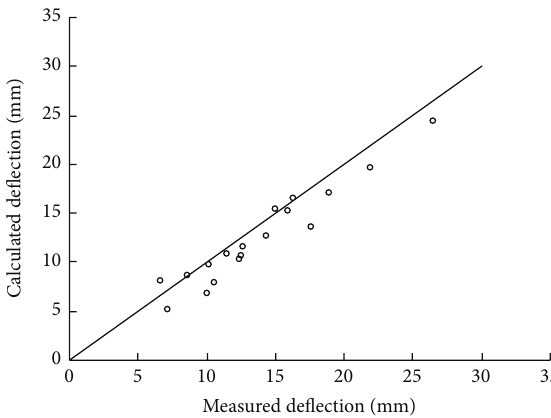
Figure 11: Comparison of the maximum deflections of the mem- brane under different pressures.